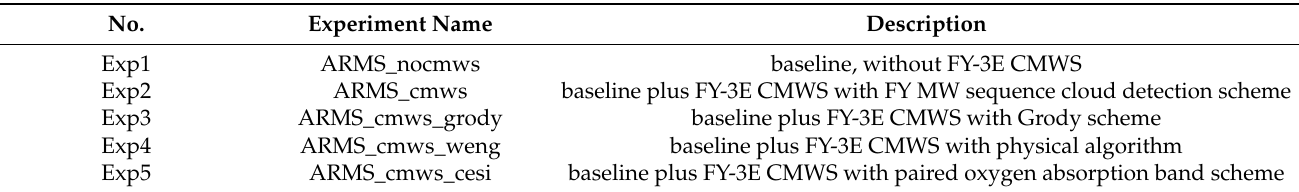
Table 3. The list of assimilation